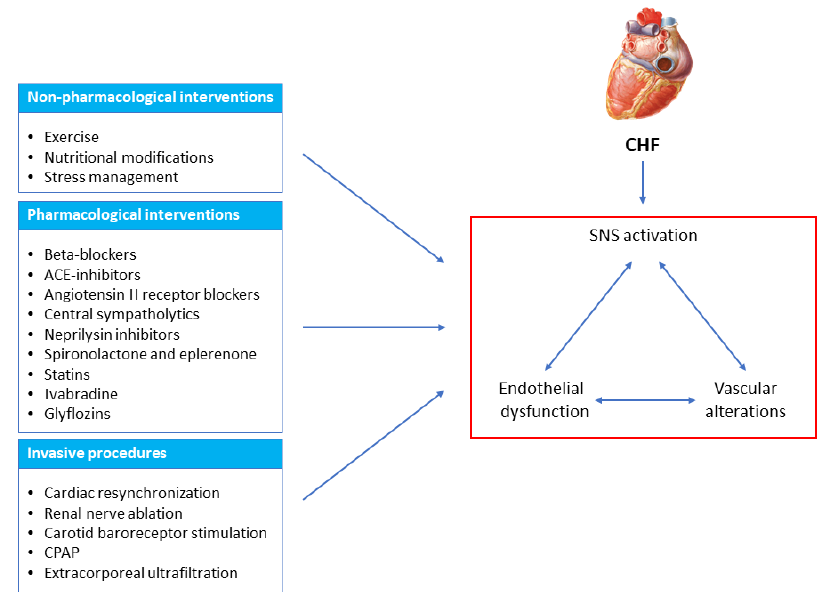
Figure 1. Scheme illustrating various non-pharmacological, pharmacological and device-based therapeutic interventions acting on the sympathetic/vascular/endothelial dysfunction characterizing chronic heart failure (CHF). SNS, sympathetic nervous system; CPAP, continuous positive airway pressure.